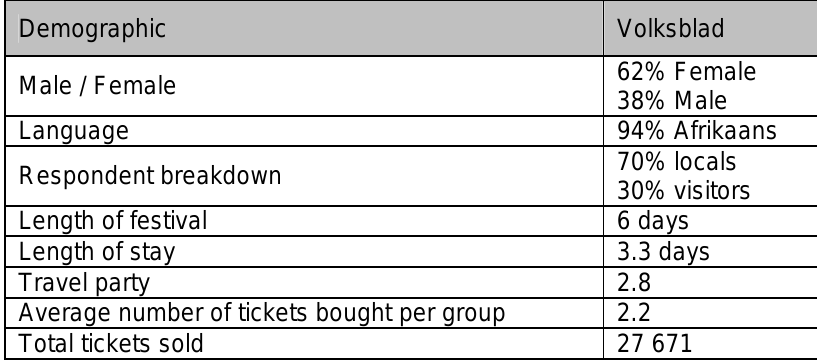
Table 2: Demographics of